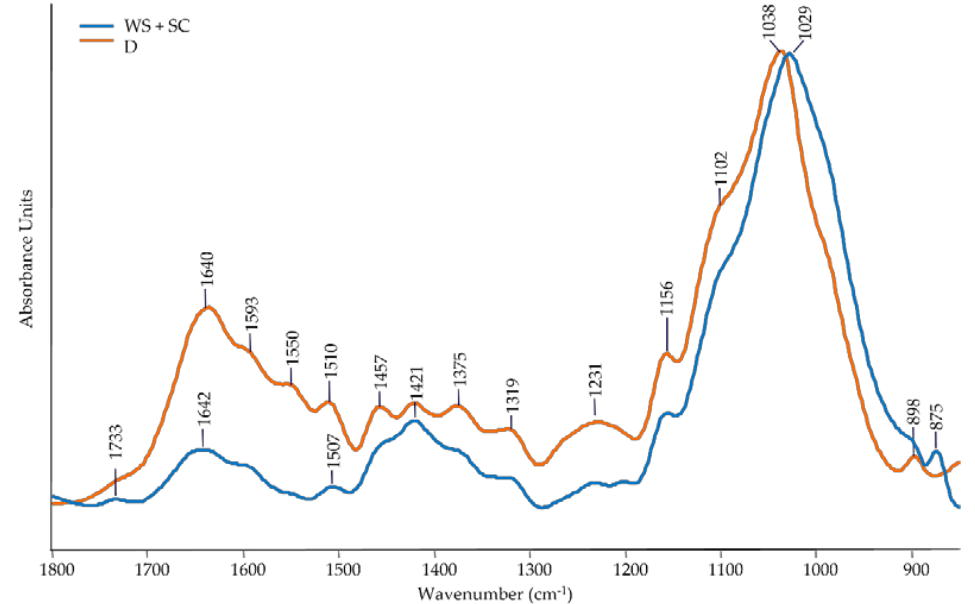
Figure 2. ATR-FTIR spectra of WS + SC (blue line) and D (orange line) before the cultivation. In addition, connected to the structure of the polysaccharides, there are two bands at 1421 cm − 1 and 1319 cm − 1 assigned to CH 2 bending at C-6 of the crystalline cellulose, and a peak at 1375 cm − 1 associated with CH 2 bending vibrations in cellulose and hemicellu- lose [24]. A small band at 1733 cm − 1 is observed, probably ascribed to the C=O stretching vibration in the ester linkage connected to the hemicellulose structure [43,44]. Lastly, the peak around 898 cm − 1 , in either WS + SC and D and that at 875 cm − 1 in WS + SC, are related to C-H deformation in cellulose. Another fundamental compound detectable in both matrices is lignin. Although it is more evident in D, both spectra show two bands around 1590 and 1510 cm − 1 attributed to the aromatic skeletal vibration and aromatic breathing in lignin, respectively [43]. The broad peak around 1640 cm − 1 is possibly due to C=O stretching in conjugated ketones, water, and Amide I (proteins), while that at 1550 cm − 1 is attributed to Amide II (proteins)